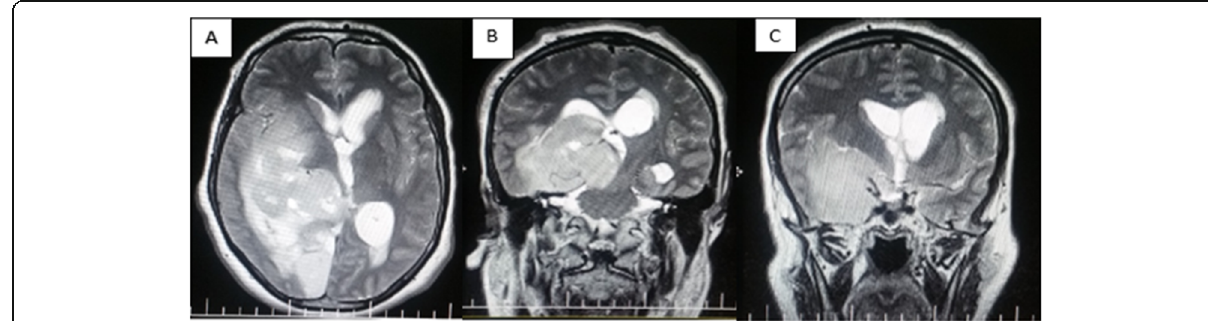
Fig. 1 a , b , c The axial and coronal views of T2-weighted MRI of the brain without contrast. The dimensions of the tumor are 100 × 60 × 50 mm in the right temporal and occipital lobes, compressing the third ventricle, midbrain, and right lateral ventricle, causing the shift of midline elements and enlargement of the left lateral